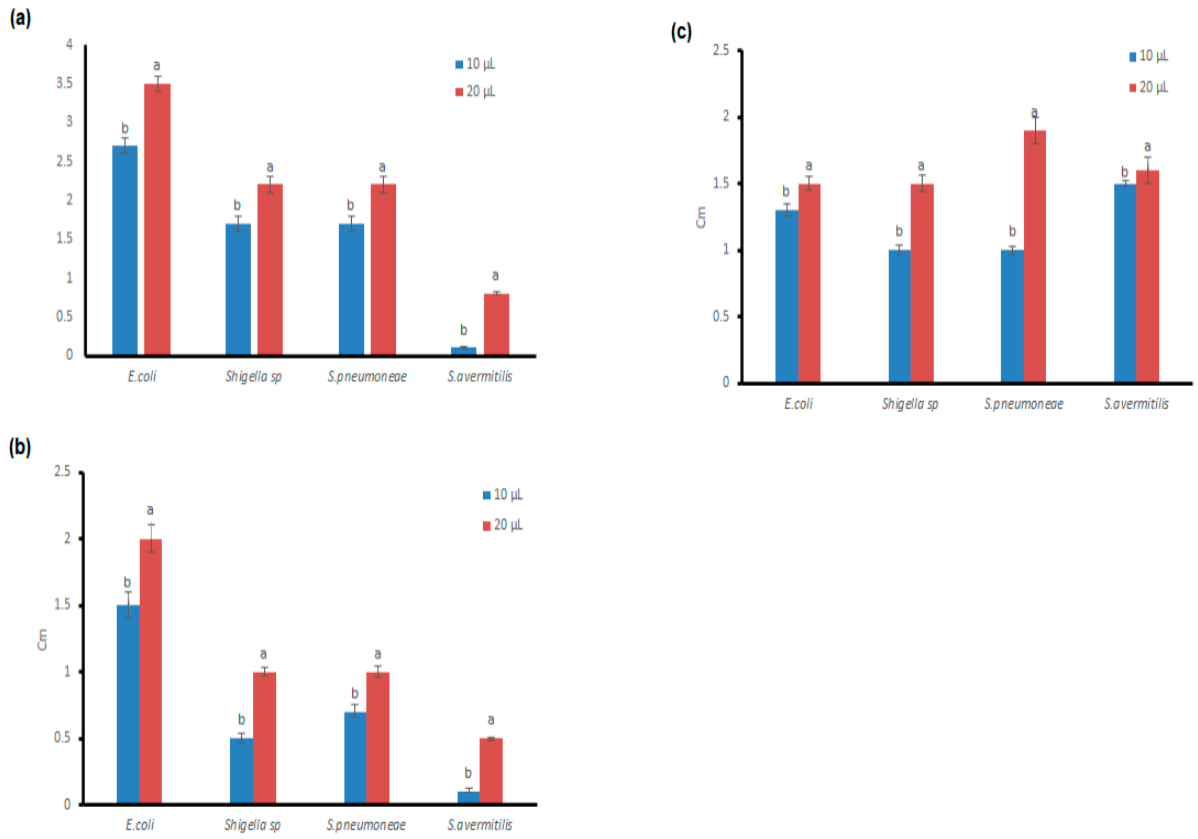
Figure 4. Antibacterial activity of the intracellular methanol extracts of ( a ) Cladosporium cladosporioides, ( b ) Graminicolous helminthosporium, and ( c ) Bipolaris australiensis against various bacterial pathogens. Data are represented as means ± SD of three replicates. If followed by different letters, the results are significantly different according to Duncan’s multiple range test at p ≤ 0.05.